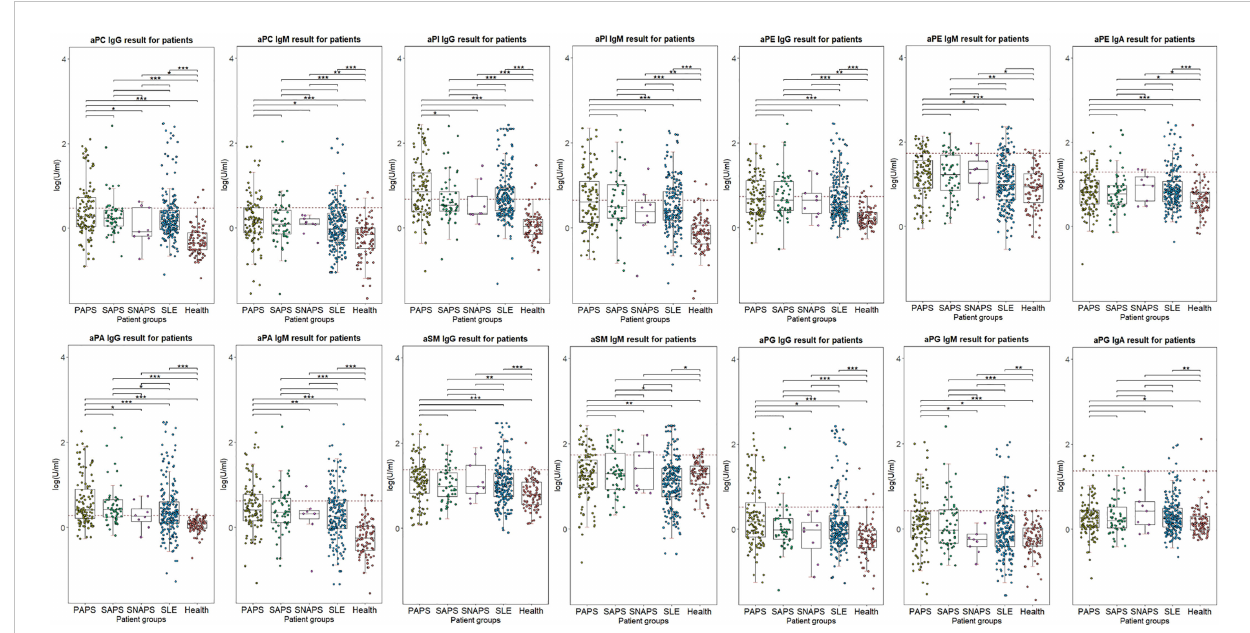
FIGURE 1 Distribution of aPLs in different patient groups. Log(test levels) was used for illustration. Cutoff value was indicated with red dotted lines. ***p < 0.001; **p < 0.01; *p < 0.05.